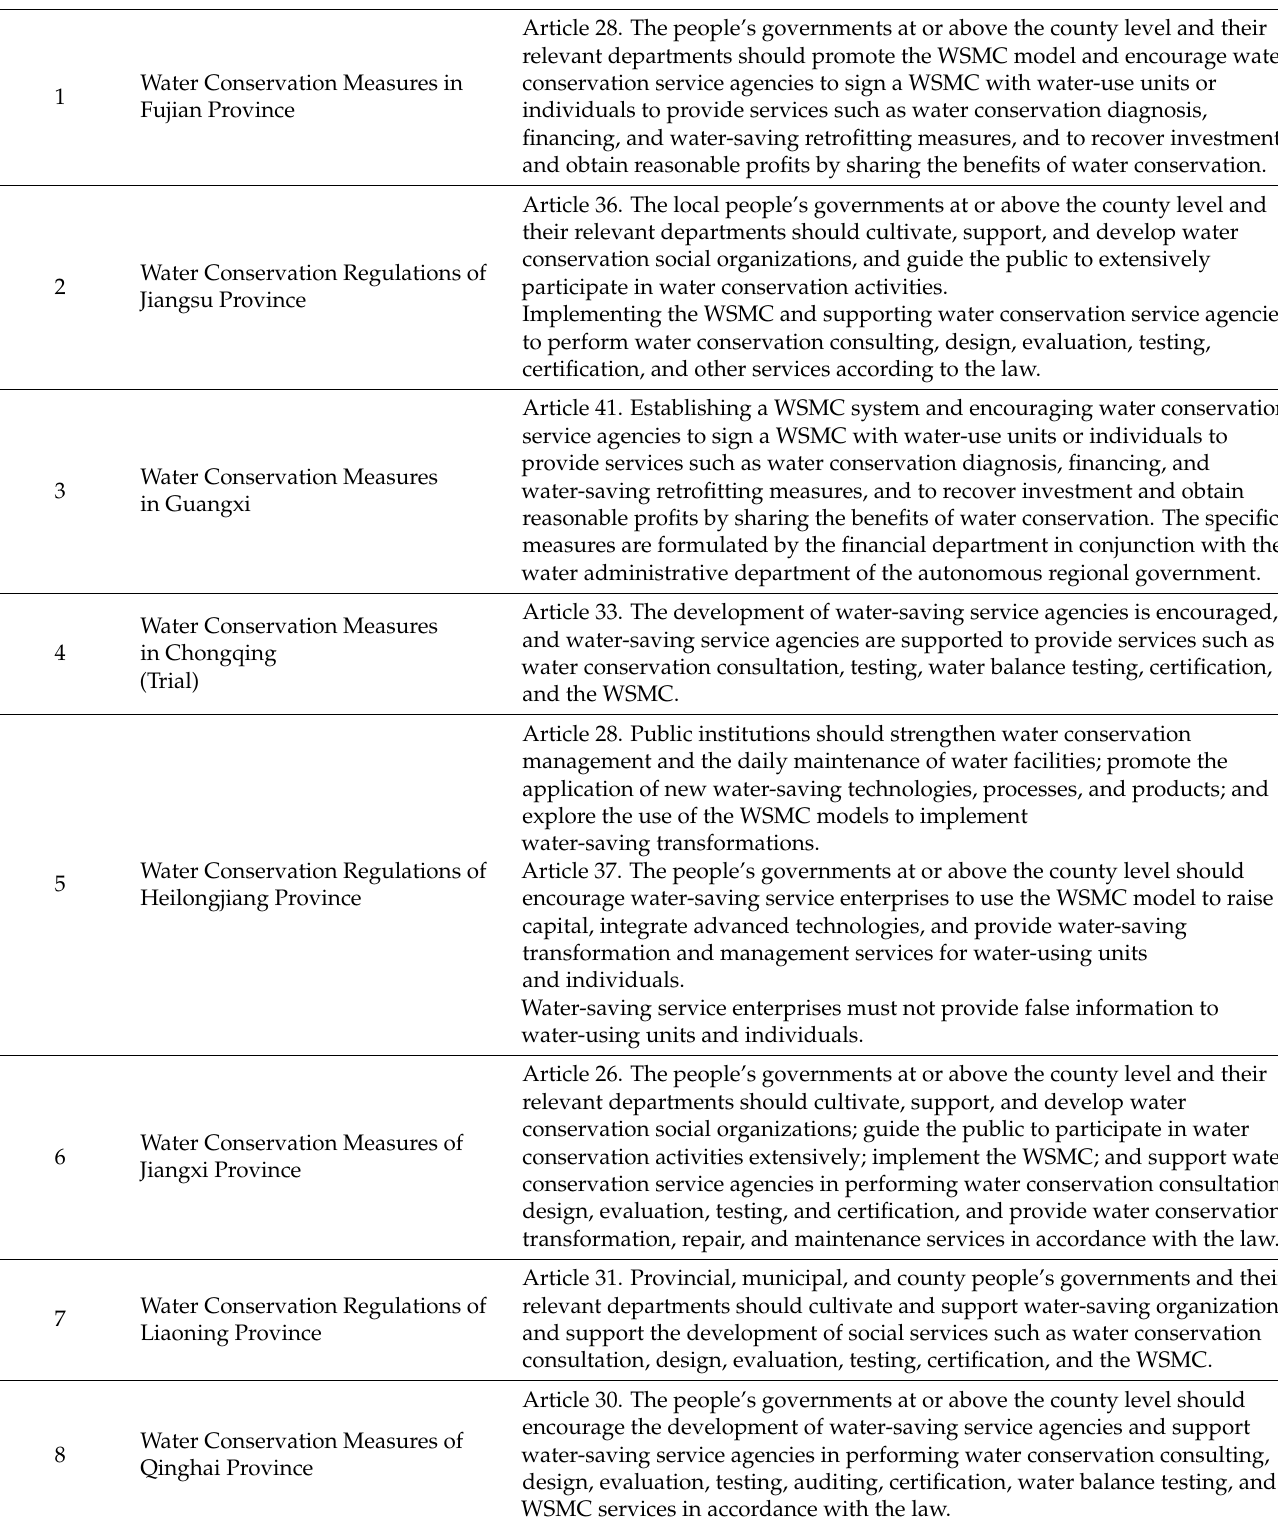
Table A2. Summary of provincial regulations that include the